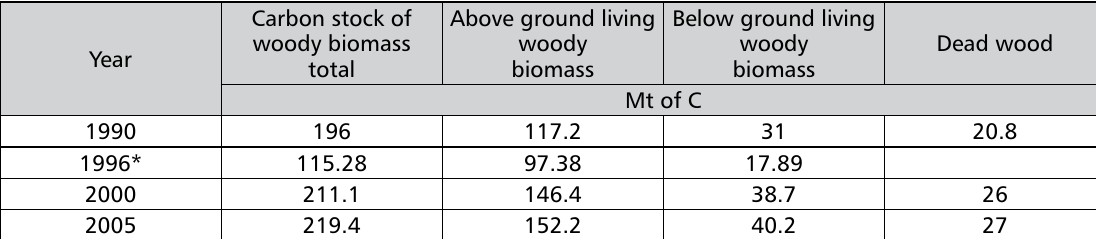
Above ground living